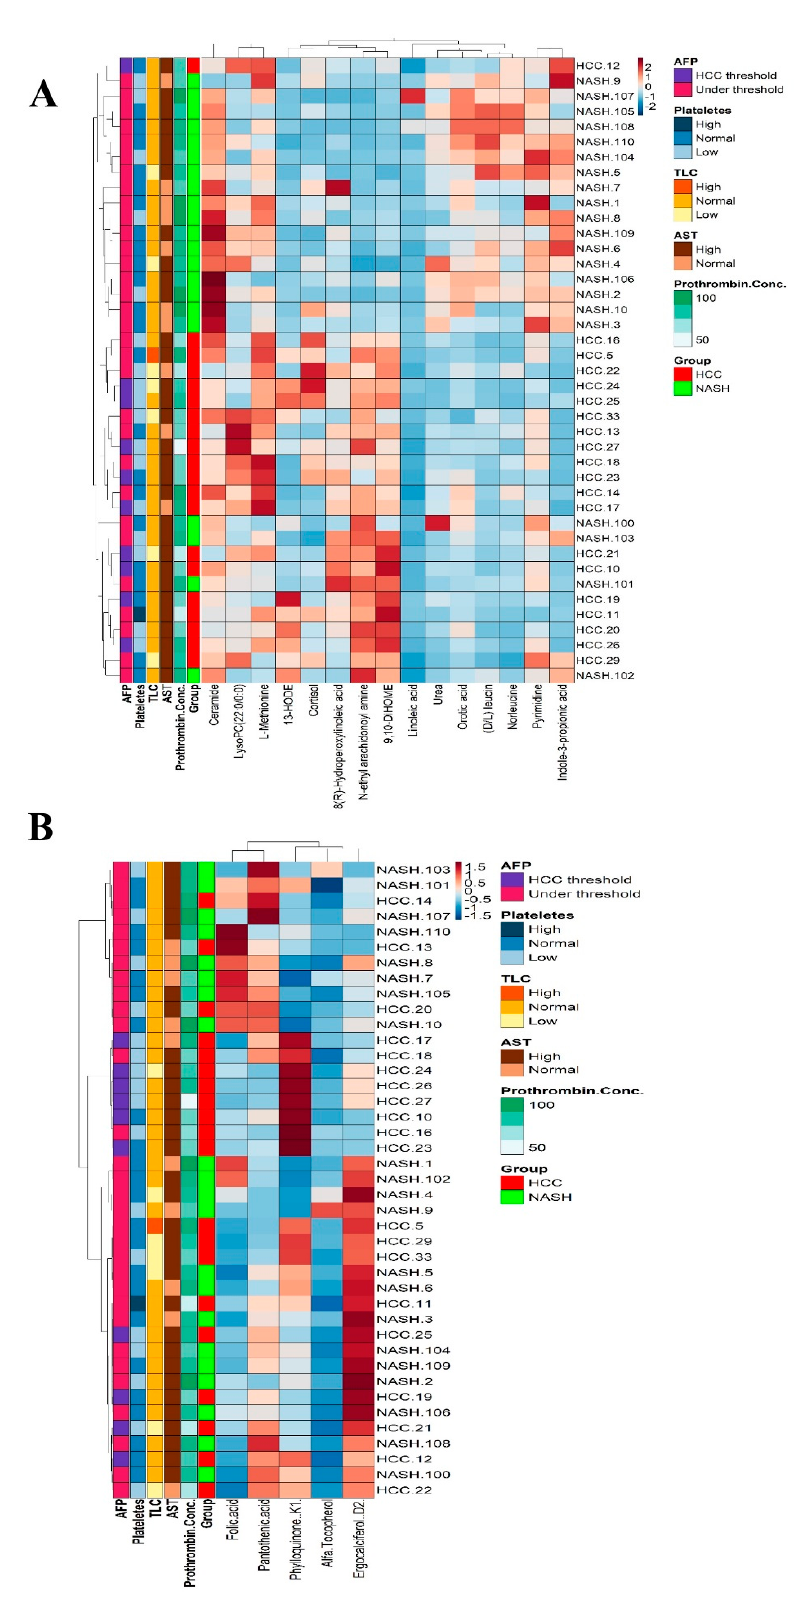
Figure 6. ( A ) Heatmap analysis showing the significant metabolites intensity for all samples with clustering. ( B ) Heatmap for upregulated and down-regulated vitamins in the NASH-HCC patients when compared to NASH patients.